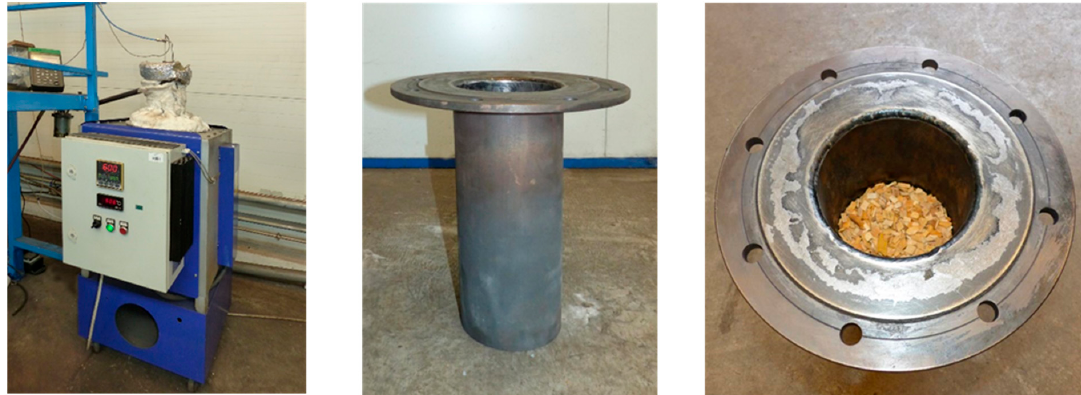
Figure 1. The electric resistance furnace and the steel retort loaded with biomass.